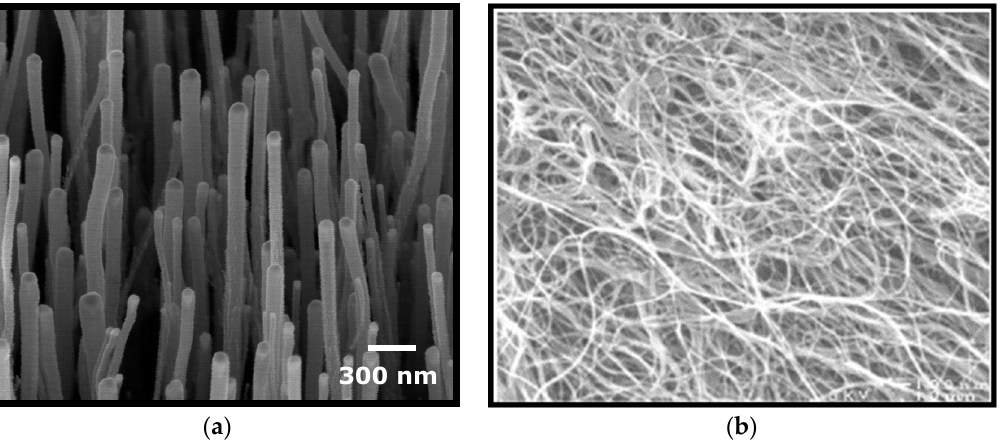
Figure 1. Examples of TEM images on multi-walled carbon nanotubes (MWCNT) used in our experiments. ( a ) MWCNT growth on a Si plate using Fe as a catalyst; ( b ) MWCNT in (spaghetti-like) growth process using Fe as a